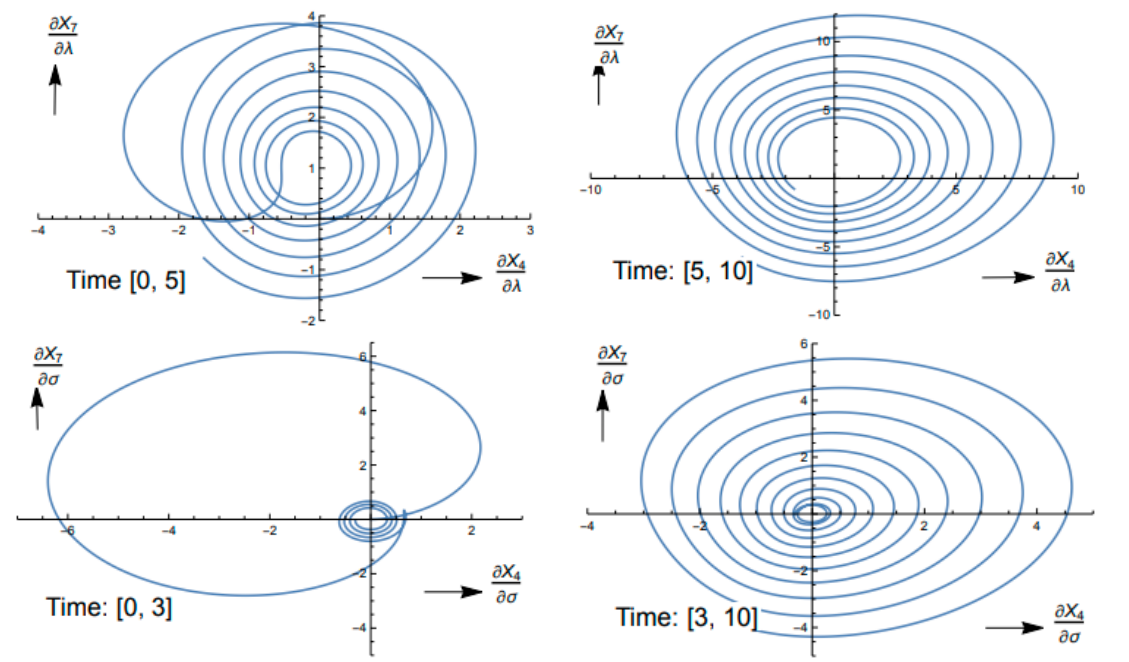
Figure 5. Phase plots of 𝑥 (cid:2872) and 𝑥 (cid:2875) forecast sensitivity over time span [0, 10] in the chaotic regime with controls 𝜆 = 28,𝜎 = 10.